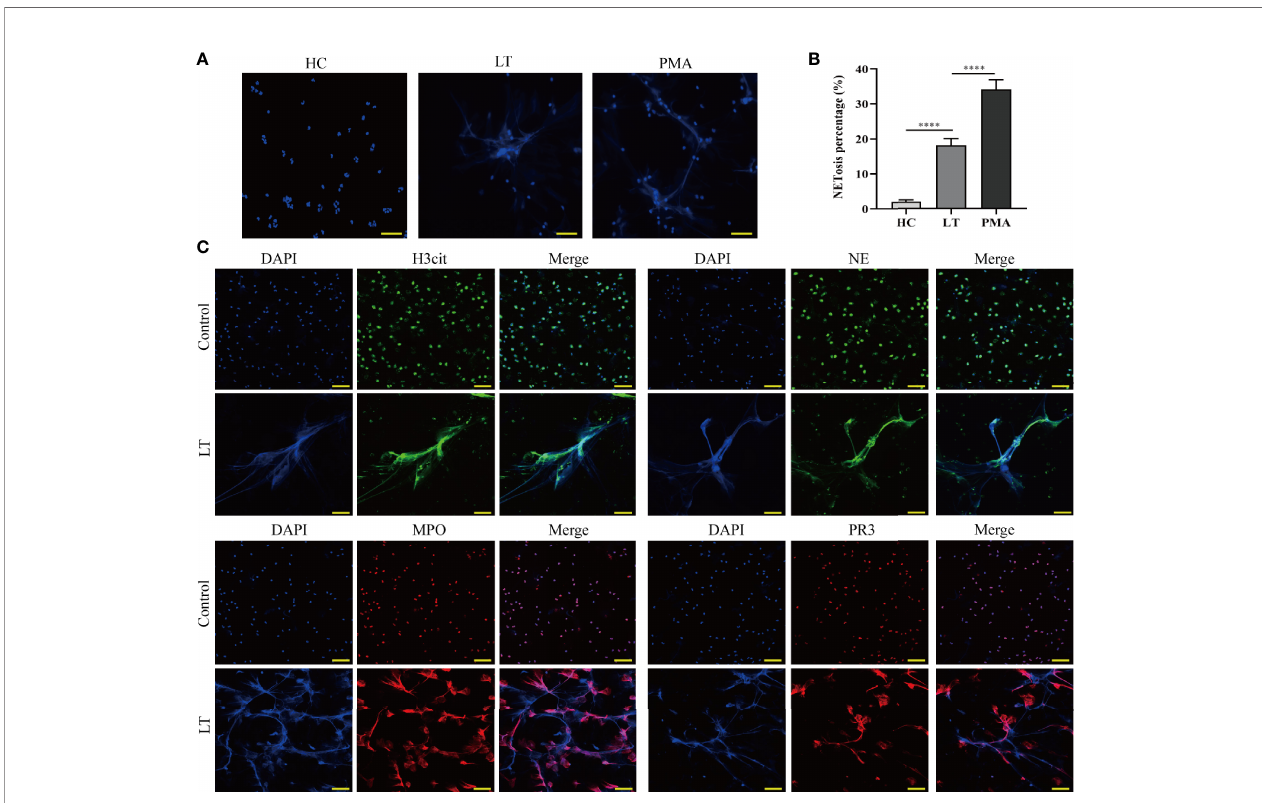
FIGURE 4 | Release of NETs from peripheral blood neutrophils in liver transplantation patients. (A) Neutrophil cells were obtained from the peripheral venous blood of healthy controls (HC) and liver transplantation patients. They were incubated at 37°C for 2 h without stimulation. PMA was used as a positive control (magni fi cation, ×200; scale bar = 100 m m). (B) Quanti fi cation of neutrophil NETosis. (C) Immuno fl uorescence assessment of NET formation as determined by colocalization of H3Cit, NE, MPO, PR3, and DAPI (magni fi cation, ×200; scale bar = 100 m m). n = 6 for each group. Data were analyzed using the chi-square test. **** P <